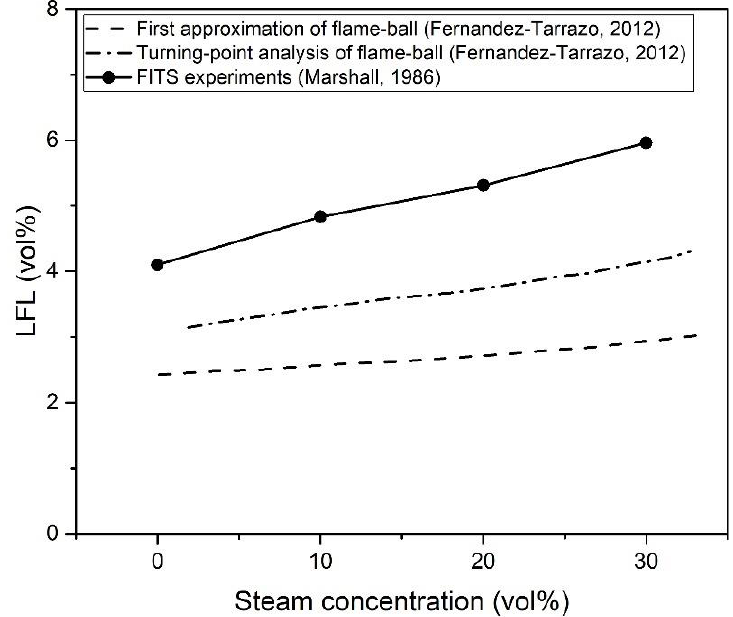
Figure 23. Predicted LFL by two analytical models based on flame ball analysis. The increase of LFL can be explained by the increasing influences of radiation. Reproduced from Ref. [23], Hydrogen Energy Publications, LLC: 2011.